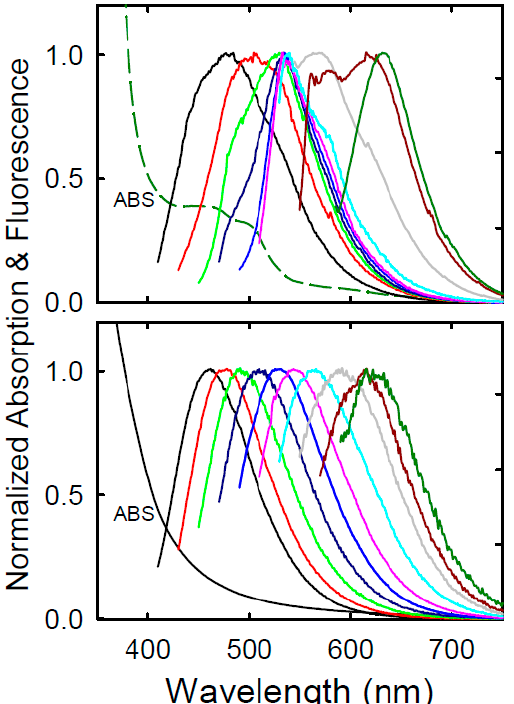
Figure 6. Absorption (ABS) and fluorescence spectra at different excitation wavelengths (from 400 to 580 nm in the 20 nm increment) of the two samples from processing the CA–FA mixture at 160 °C for 1 h (upper) and at 300 °C for 2 h (lower) are compared.